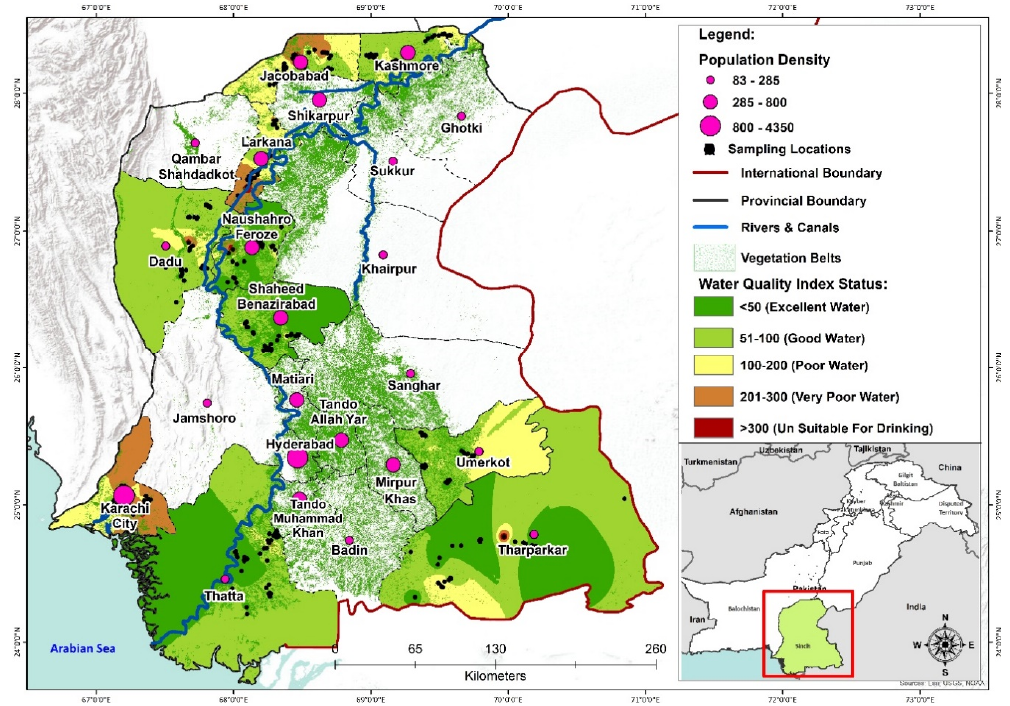
Figure 5. Water Quality Index showing population density, agriculture density, and proximity to the sea.